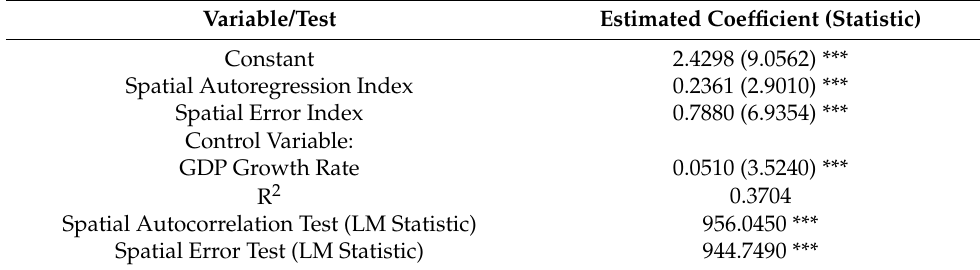
Table 4. Calculation results of spatial autoregression error